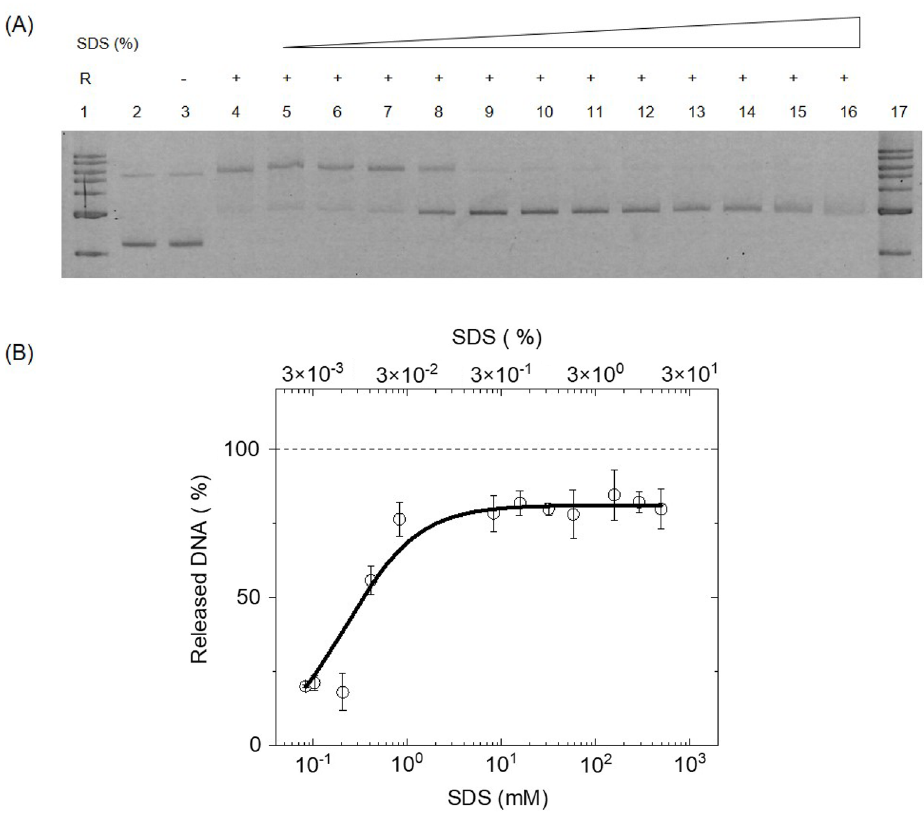
Figure 4. Quantification of SDS dependent release of Cas9 cleaved products. ( A ) Gel image showing the DNA release as a function of SDS %. Lane 1 and 17: 1 kb ladder, lane 2: control DNA, lane 3: DNA + apo- Cas9 at 37 °C, lane 4: DNA + Cas9.RNA at 37 °C, lanes 5–16 show the release of cleaved products at final concentrations of SDS—0.083 mM, 0.10 mM 0.21 mM, 0.41 mM, 0.83 mM, 8.3 mM, 16 mM, 32 mM, 58 mM, 0.16 M, 0.29 M and 0.50 M. respectively. ( B ) Plot showing % DNA released as a function of SDS concentration. The mean and error bars are from N = 3 independent experiments (see also Fig. S5). Solid line is fit to Eq.